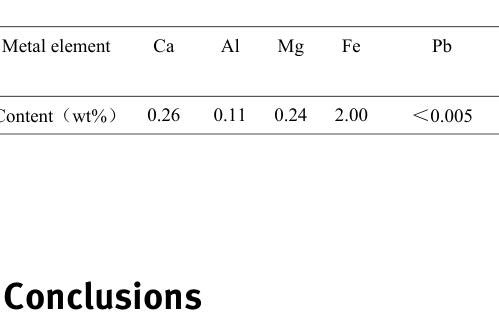
Table 4: Metal element content of silicon oxide nanofiber.